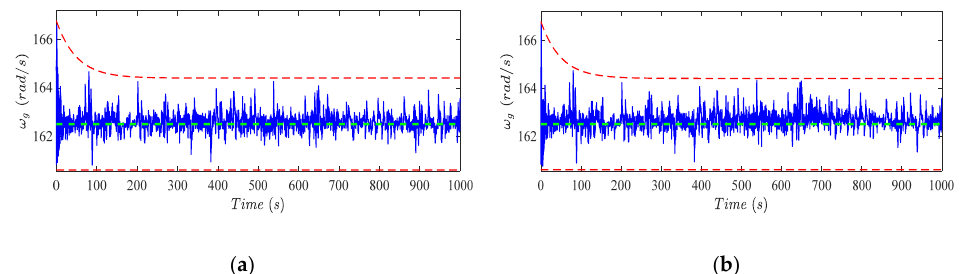
Figure 7. Generator speed ω g (blue line) with constructed constraints (red dashed lines) and nominal value (green dashed line), under single ( a ) and simultaneous faults ( b ).